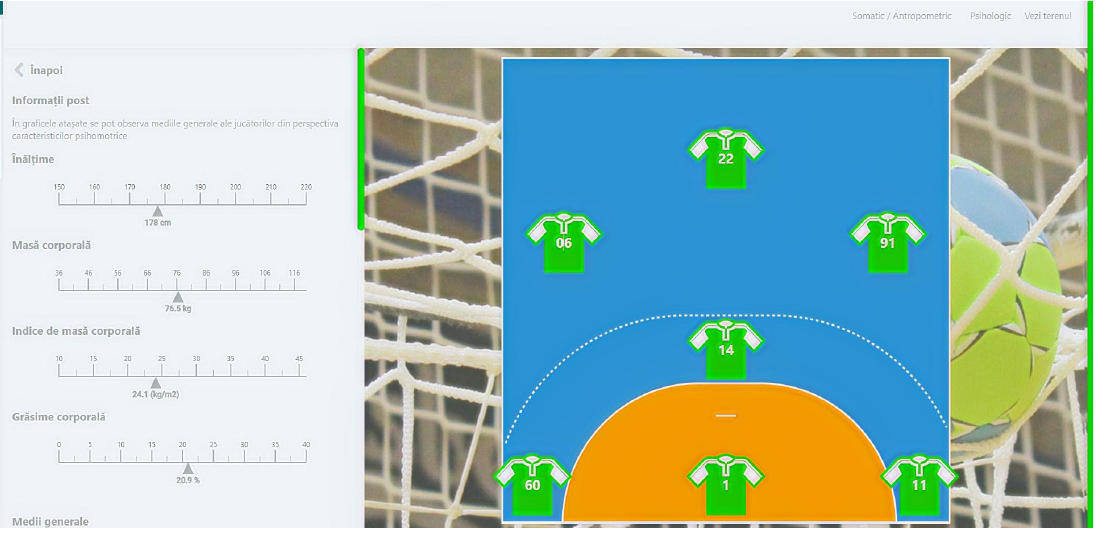
Figure 3. Representation of the software’s third page.